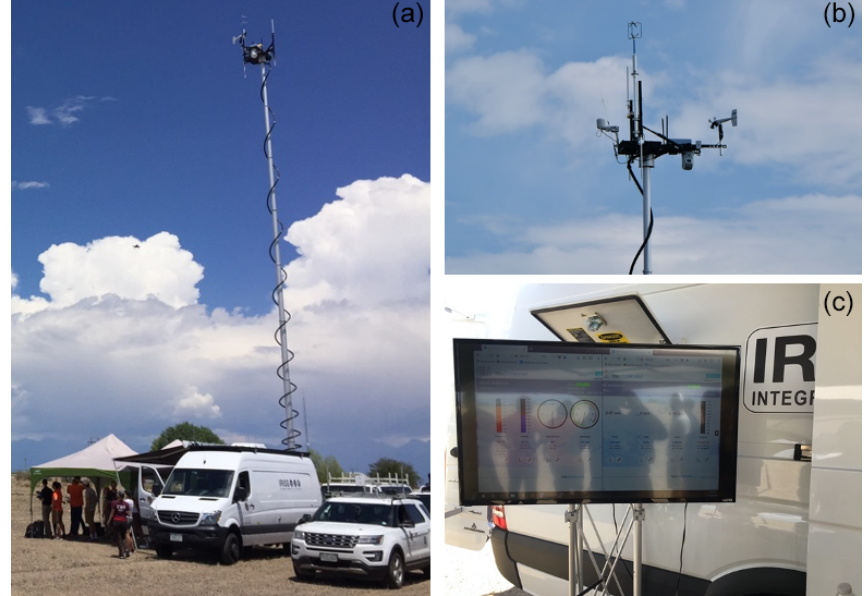
Figure 1. The CU MURC vehicle, with mast extended (a) , as deployed during LAPSE-RATE. The right hand panels show the instrument cluster mounted on the top of the MURC mast (b) and the MURC real-time data display (c) . Table 1. Sensor specifications for the CU